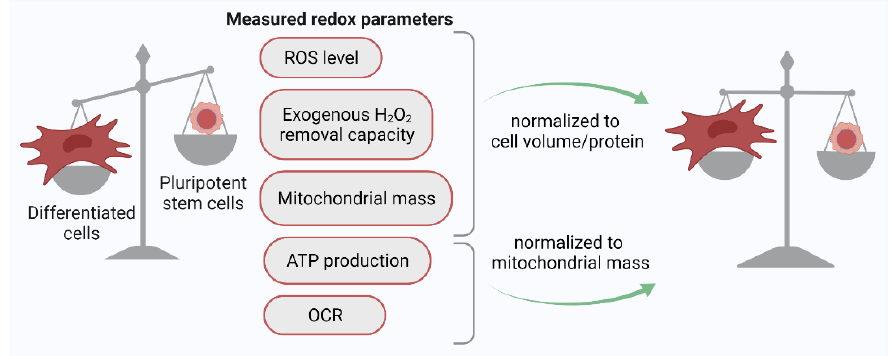
Figure 1. Normalization of key redox parameter values to cell protein/volume or mitochondrial mass leads to the leveling of these parameters between PSCs and their differentiated progeny cells. ROS, reactive oxygen species; OCR, oxygen consumption rate.